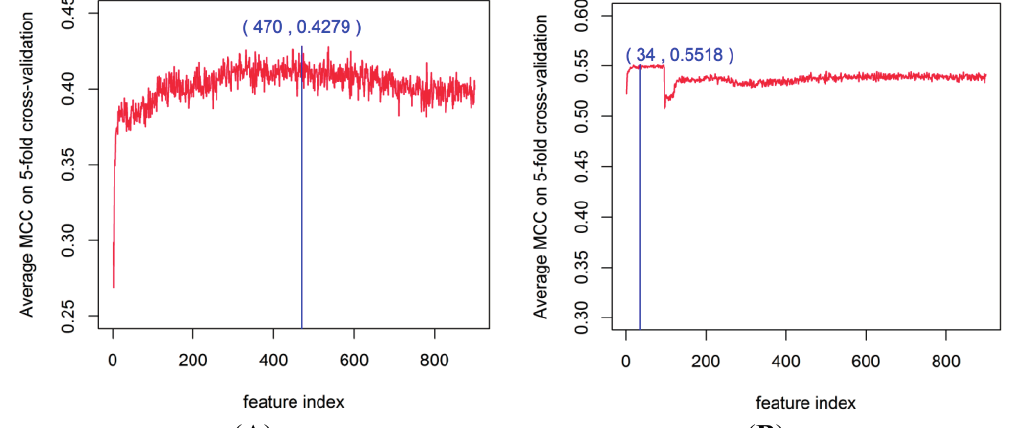
Figure 5. Matthews correlation coefficient (MCC) of DXEC-RF by adding features sequentially on the Yeast dataset. ( A ) The MCC result on the Gold; ( B ) The MCC result on the